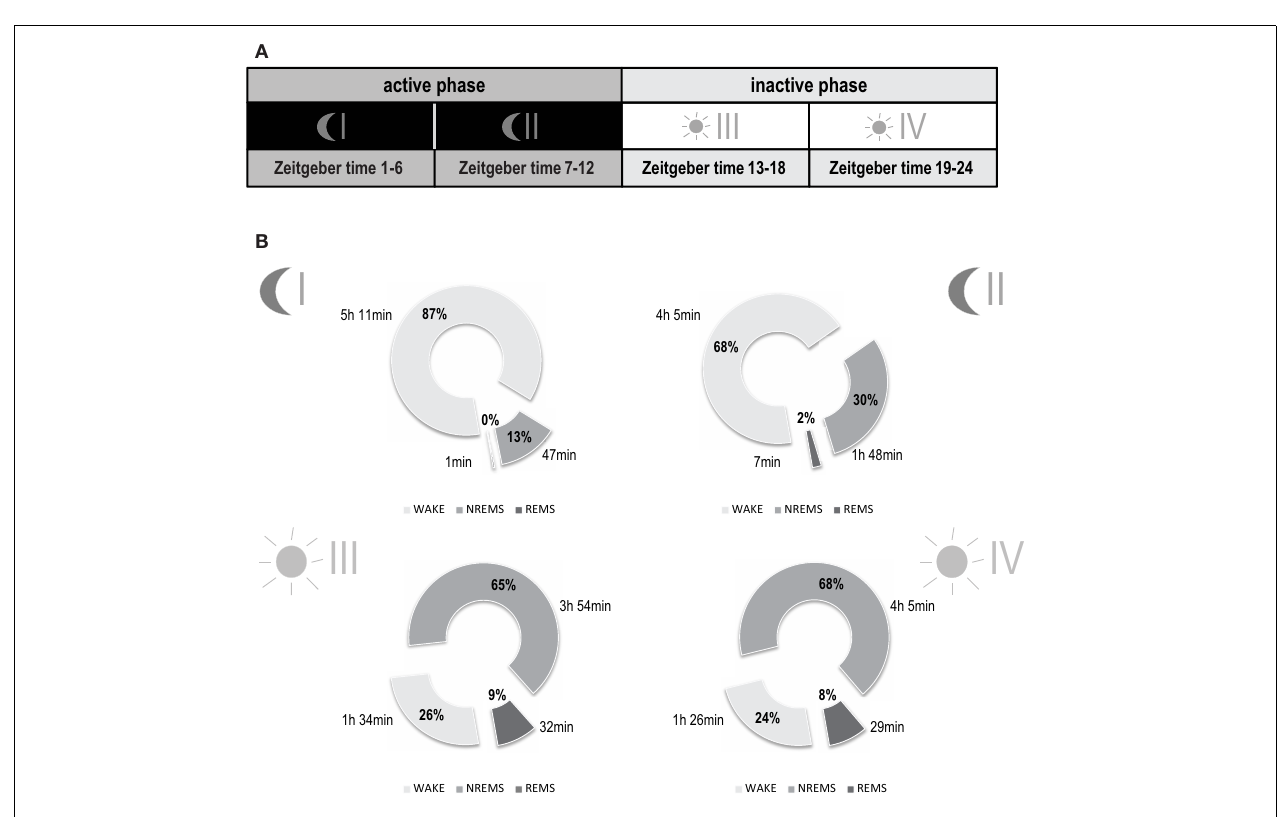
when comparing the two experimental groups (shocked vs. non-shocked, 2-way ANOVA). Phase I [Mean ± SEM (%)]:WAKE, non-shocked: 83.0 ±